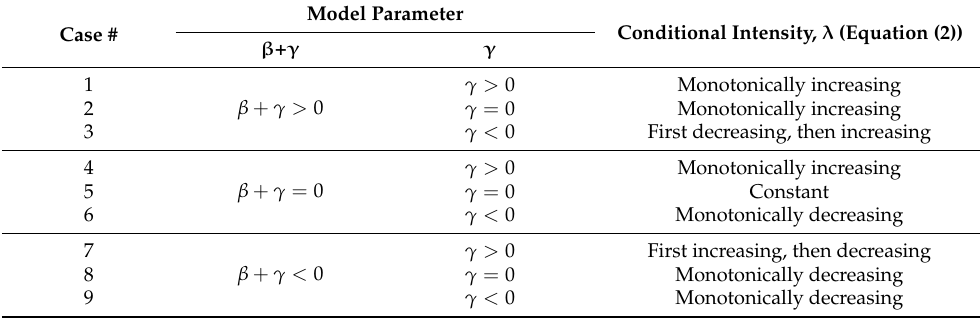
Figure 2. Three-dimensional plot of λ against model parameter β and the sojourn time w given α = 0.1, β = 0.6, γ = − 0.3, and T L = 20. Table 1. Summary of deterioration trends captured by the TTS model with respect to permutations of model parameters (after Lin and Yuan [34]).